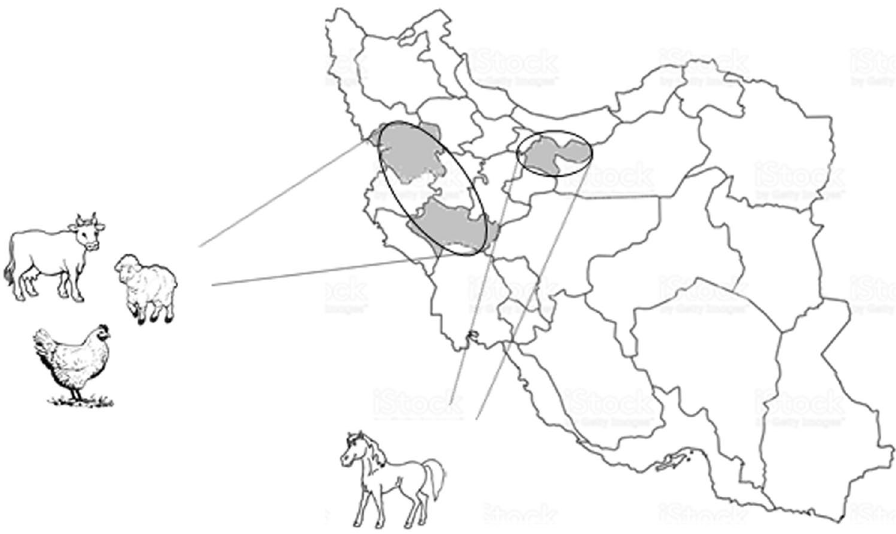
Figure 3. Iran map highlighting the sampling sites. The raw map was downloaded from free web source: https:// commo ns. wikim edia. org/ wiki/ Atlas_ of_ the_ world and edited with Photoshop cc by Hanieh Mohammad Rahimi.